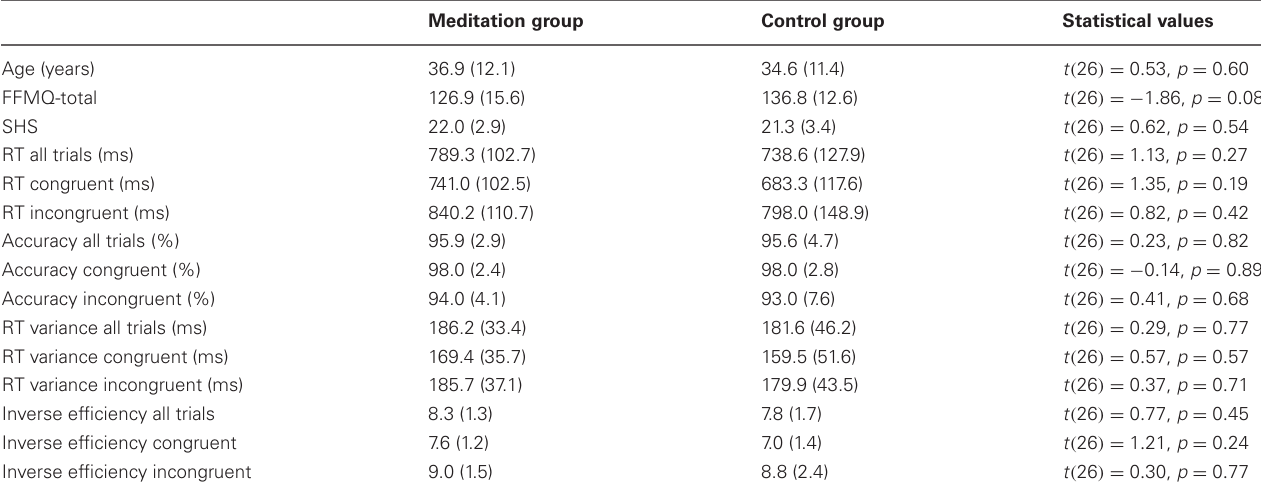
Table 1 | Summary of tests for baseline differences, with mean values, standard deviations (in brackets), and respective statistical values for the comparison between meditation group and control